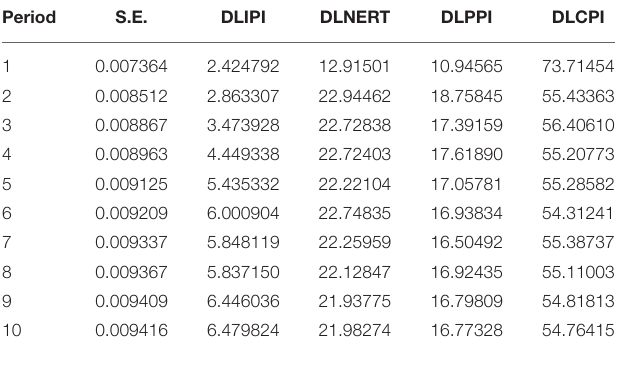
TABLE 3 | Variance decomposition of